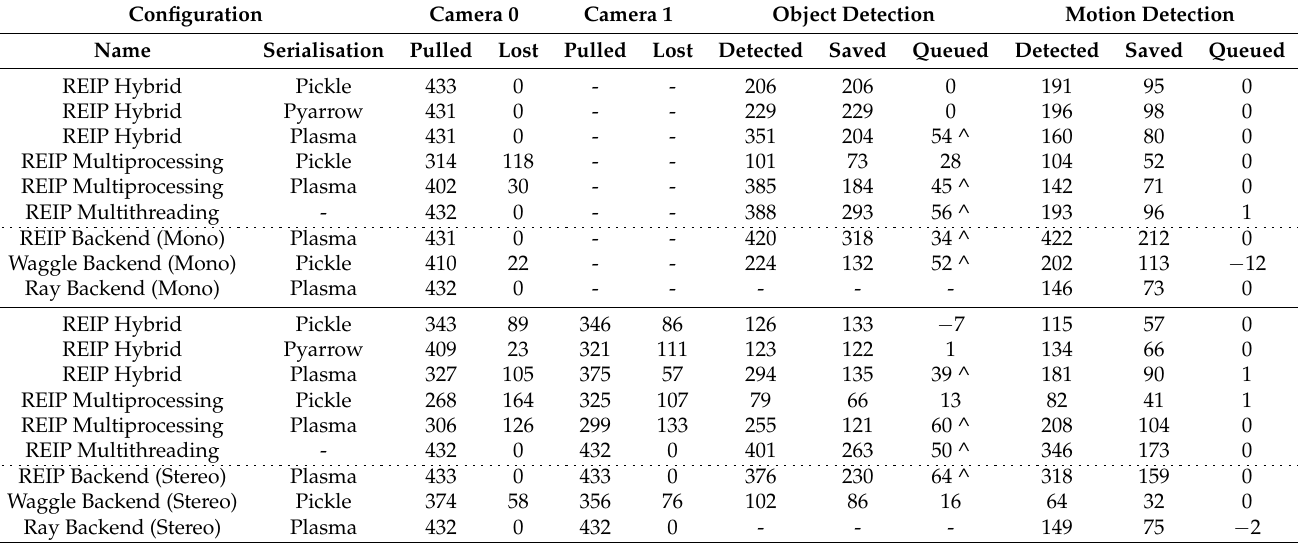
Table 2. Performance of different framework configurations when running a video processing pipeline (Figure 4a) on Jetson Xavier NX. Values denote number of frames processed by different blocks in the pipeline during 30 s sampling period. Top half of the table corresponds to the mono and bottom half to the stereo camera configuration. The system was throttled to use 4 CPU cores only to be able to measure more subtle performance differences between different configurations. Negative queued values indicate extra frames processed that have already been in the queue prior to the sampling interval. Symbol ^ indicates queue overflow (max queue size was set to 100